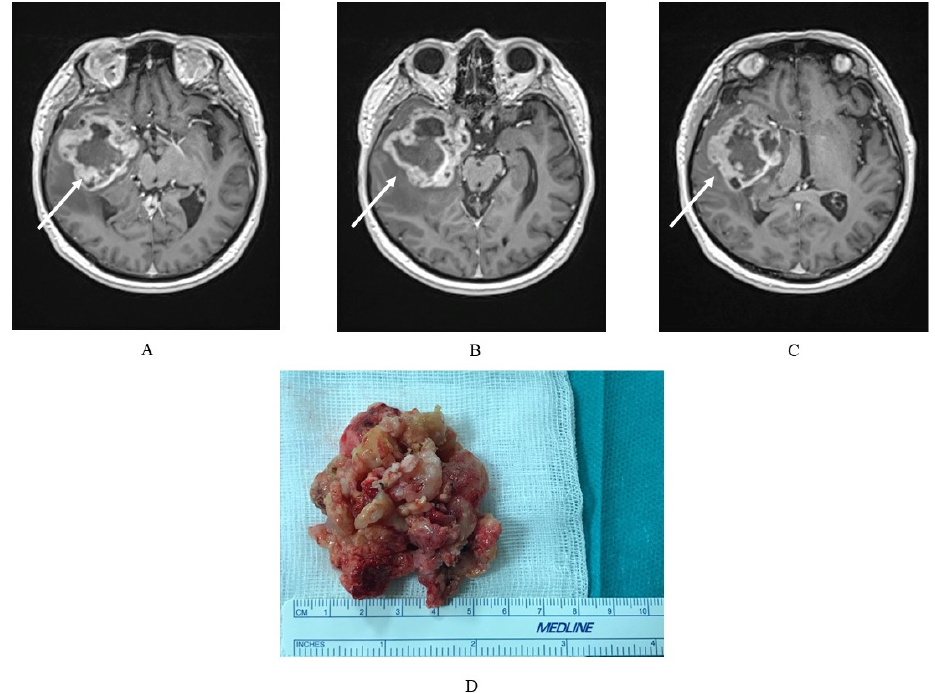
Figure 1. ( A – C ) Magnetic resonance imaging (MRI) exam of a glioblastoma multiforme (GBM) in a 75-year-old patient with a tumor localized in the right temporal lobe with a heterogeneous signal, and, characteristically for GBM, strong, irregular, marginal contrast enhancement and ( D ) the GBM tumor mass of the same patient, where macroscopically a visible, heterogeneous structure is typical.